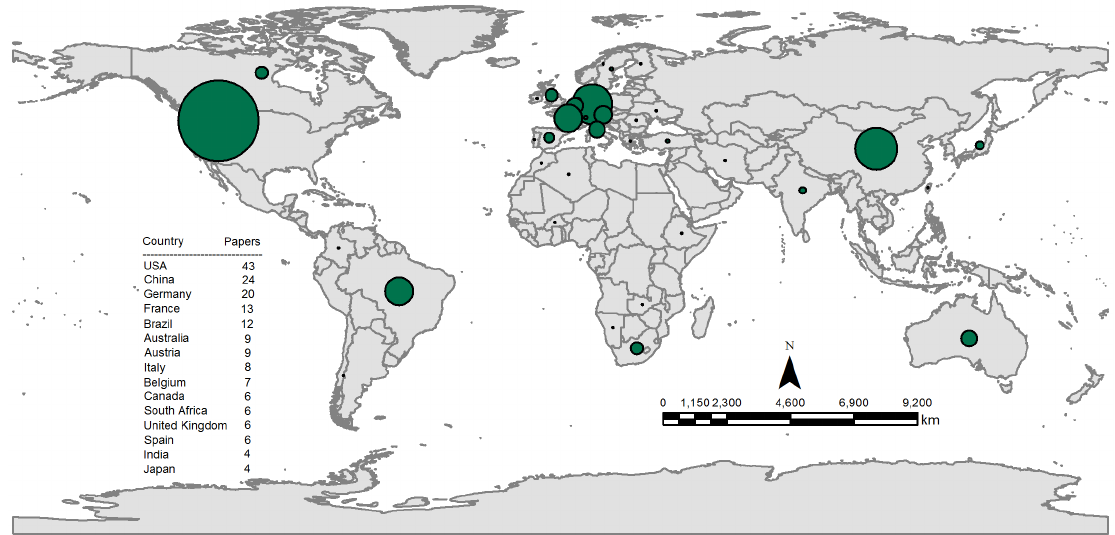
Figure 2. Global distribution of the research groups responsible for the papers selected, highlighting the 15 countries with the greatest number of publications.